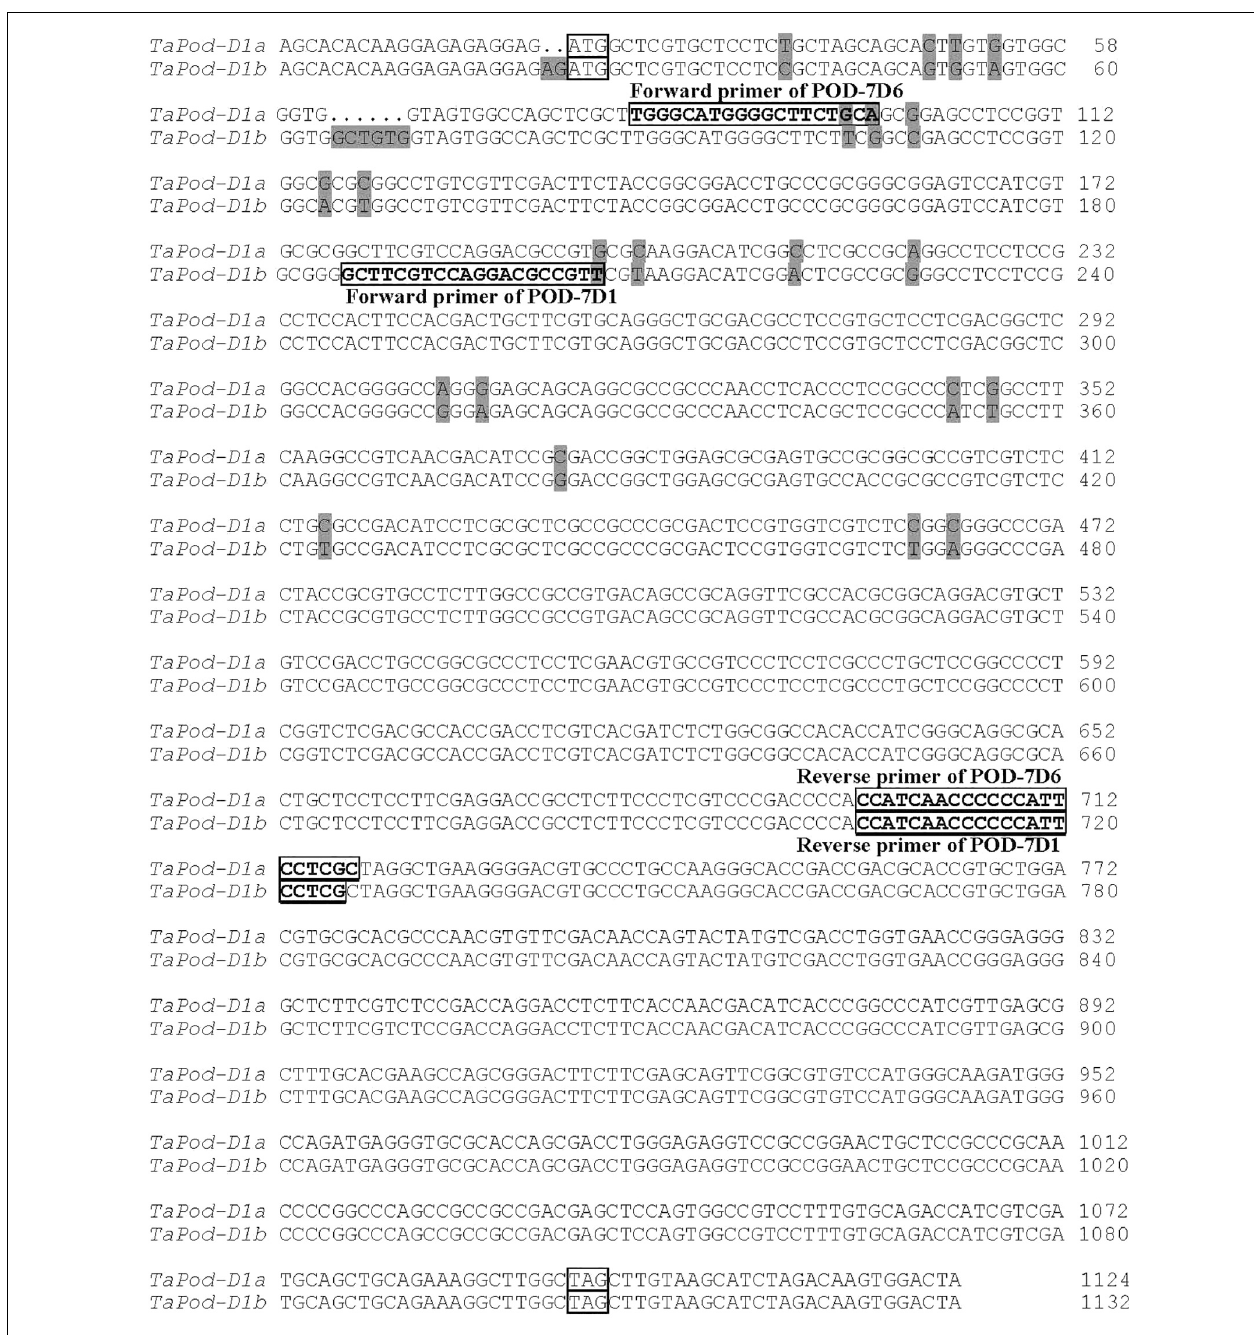
FIGURE 8 | Alignment of alleles TaPod-D1a and TaPod-D1b mapped on wheat chromosome 7D. The initiation and termination codons are boxed ; the SNPs are shadowed ; the forward and reverse primers of POD-7D6 and POD-7D1 are boxed and bold